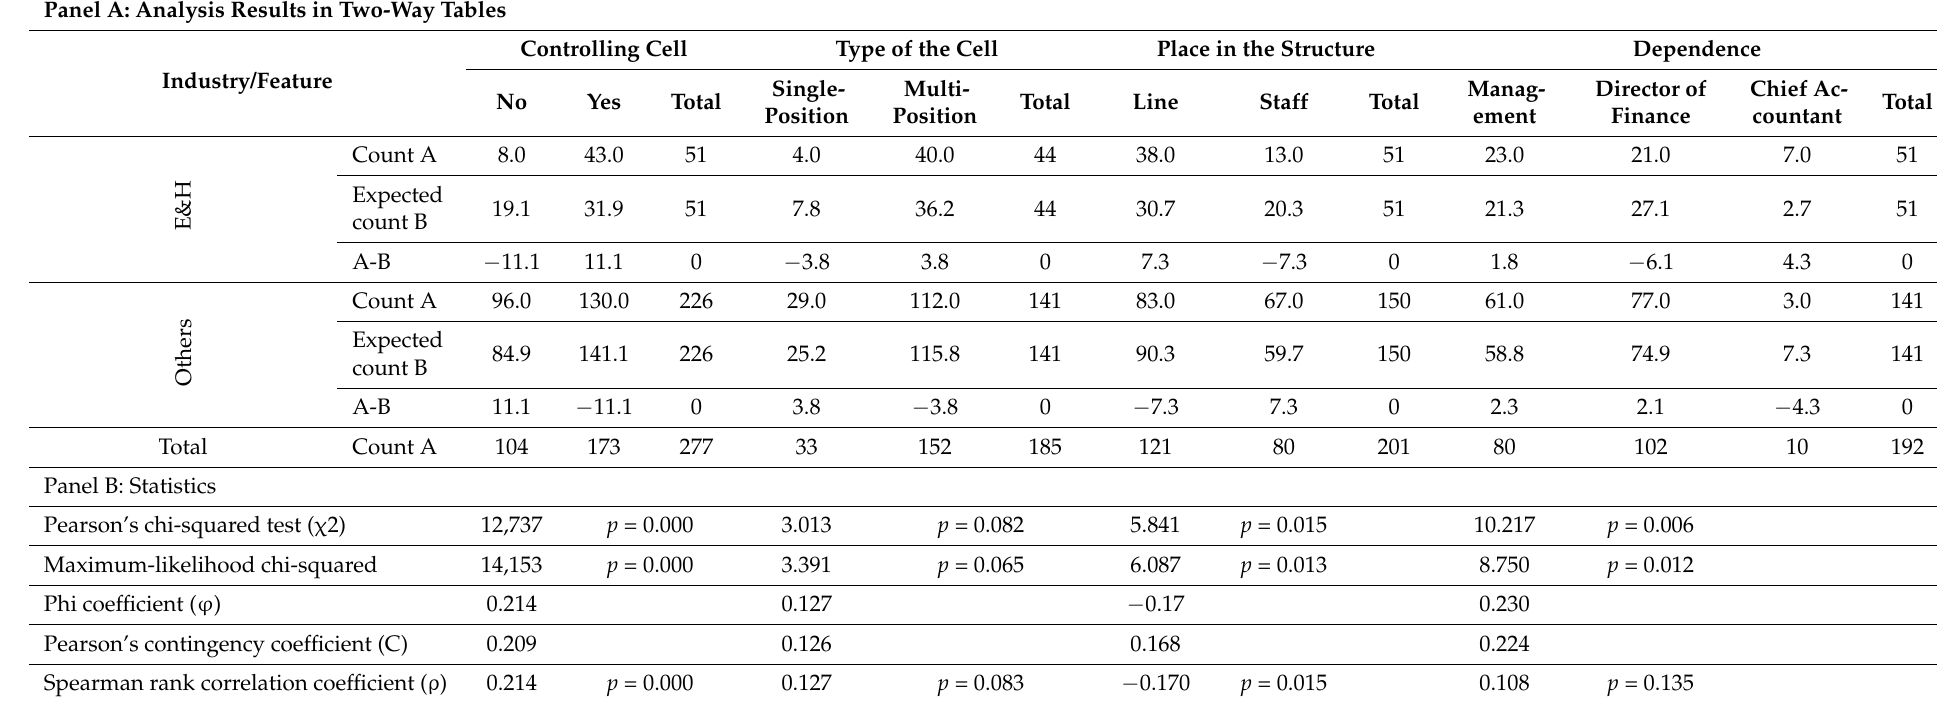
Table 3. Organization of the controlling function in the surveyed